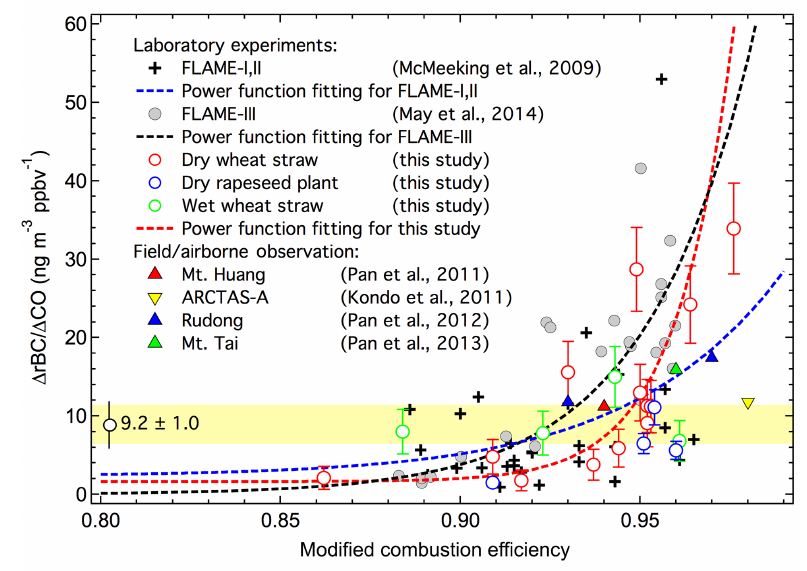
Figure 3. The variations in the emission ratios of rBC and (cid:49) rBC /(cid:49) CO, as a function of averaged MCE for all burning cases. Previous observations and the results of laboratory burning experiments are displayed in the